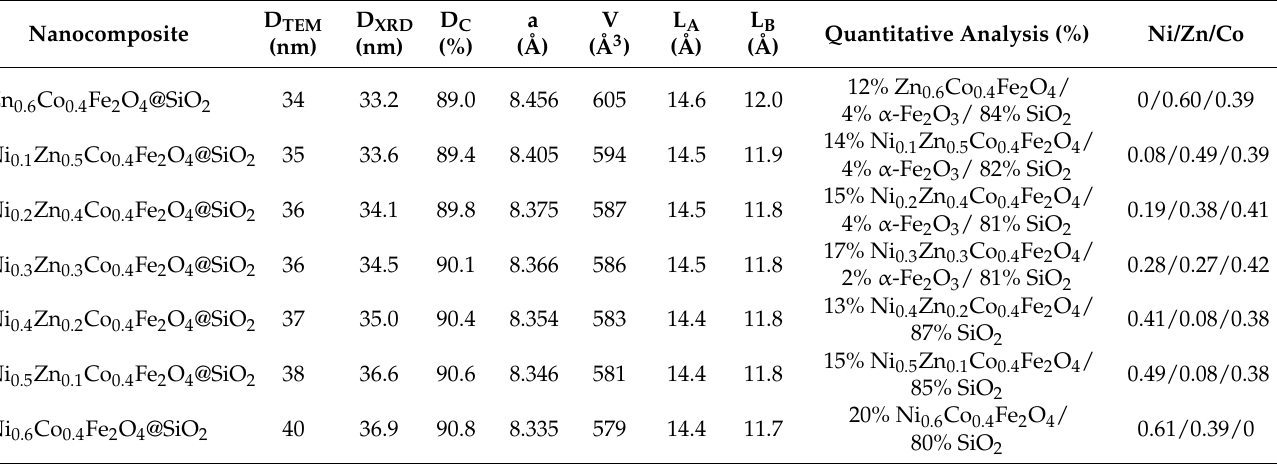
Table 1. Parameters obtained from TEM, XRD and ICP-OES analysis for samples thermally treated at 1000 ◦